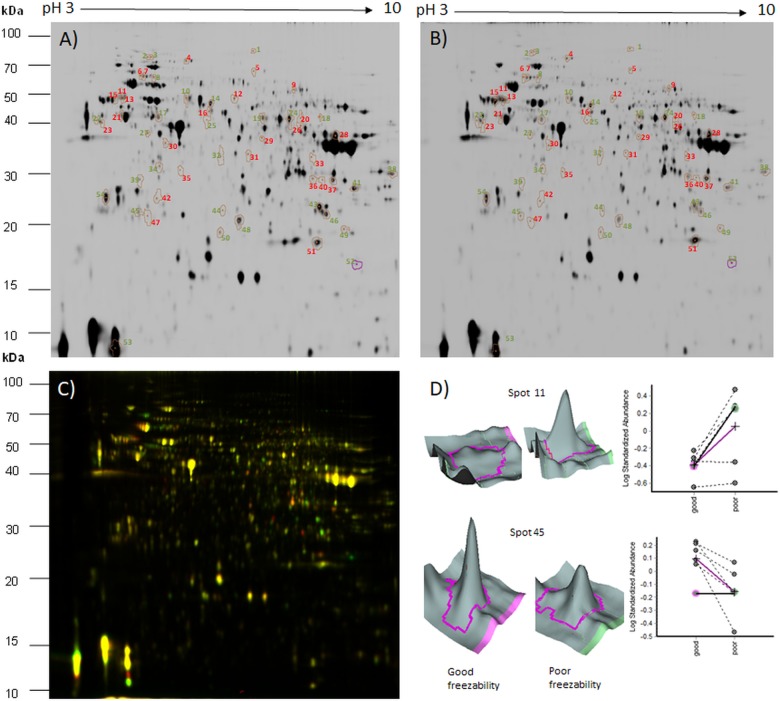
The representative pattern of spermatozoa proteomes of good (A) and poor (B) freezability semen after 2D-DIGE analysis. C-overlay of spermatozoa of good (GF) and poor (PF) semen (Cy5 [red]—spermatozoa of PF; Cy3 [green]—spermatozoa of GF). Numbers indicate spots with significantly different abundances between the spermatozoa of the GF and PF groups (red numbers indicate proteins more abundant in spermatozoa of PF, green numbers indicate proteins more abundance in spermatozoa of GF semen). (C)- the 3-D (representative images) and line charts (data for six males) of the chosen spots (spot 11- protein kinase C and casein kinase substrate in neurons protein 2 and spot 45—meichroacidin-like sperm-specific axonemal protein).